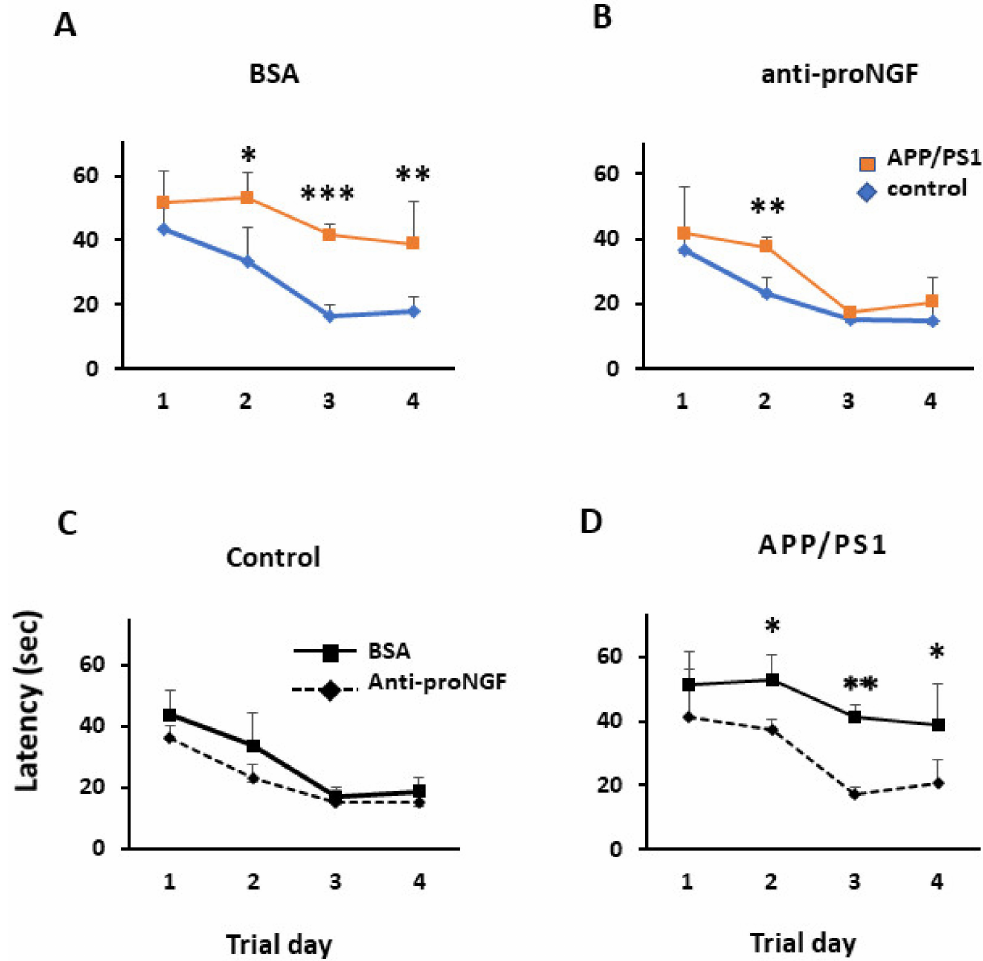
Figure 3. The injection of anti-proNGF antibody recovers the memory impairment in APP/PS1 mice ( A ) Morris water maze test in animals injected with BSA. Results show a higher latency in finding the hidden platform (latency (sec)) in the APP/PS1 transgenic mice (red line) compared to the control animals (blue line); ( B ) Morris water maze test in animals injected with anti-proNGF antibody. Results show a similar latency (sec) in the APP/PS1 transgenic mice (red line) compared to control animals (blue line); ( C ) Morris water maze test in control animals injected with BSA (solid line) or with anti-proNGF antibody (dashed line). Results show a similar latency in control animals injected either with BSA or with anti-proNGF antibody; ( D ) Morris water maze test in APP/PS1 animals injected with BSA (solid line) or anti-proNGF antibody (dashed line). Results show a significantly higher latency (sec) in the APP/PS1 transgenic mice when injected with the antibody (dashed line) compared to the injected with BSA. ( n = 5 mice per group). p ≤ 0.05 (*), p ≤ 0.01 (**) or p ≤ 0.001